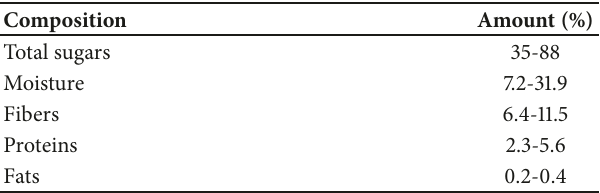
Table 1: Chemical composition of dates [2, 7].